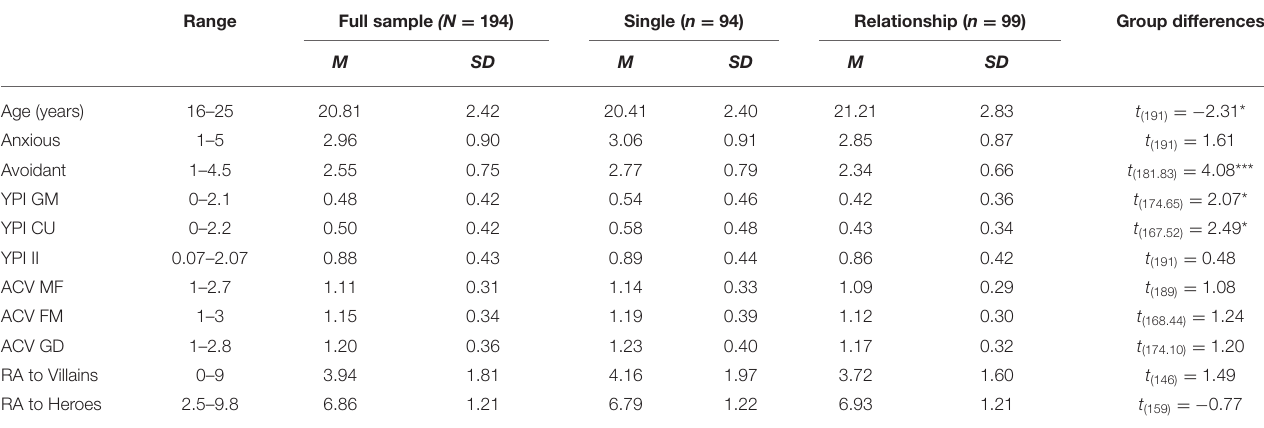
TABLE 4 | Descriptive statistics in Study 2 (Main Study).